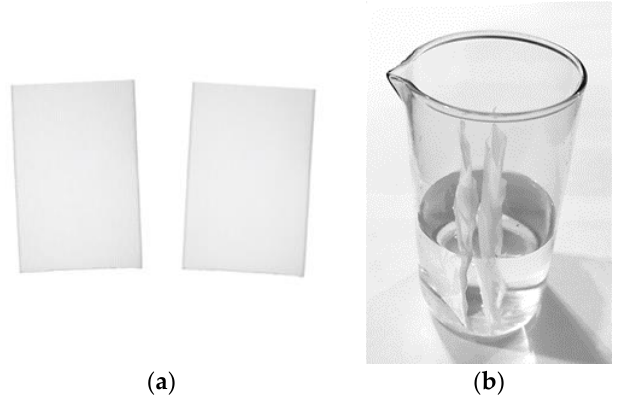
Figure 1. ( a ) Polypropylene meshes; ( b ) Illustration of the activation process of the interpolymer system.